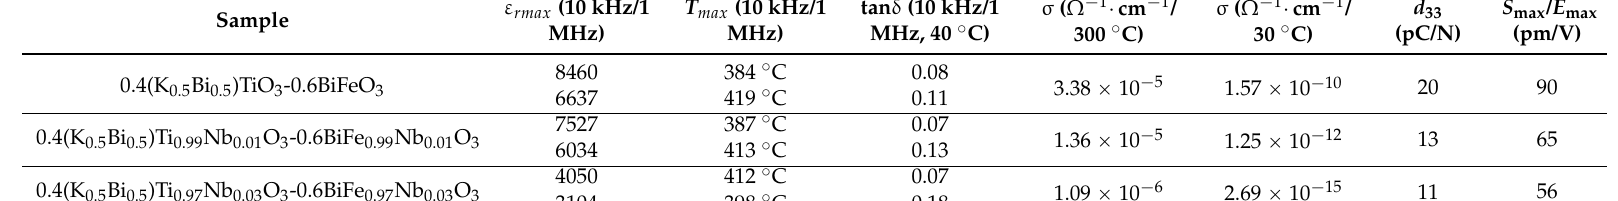
Table 2. Electrical properties of (K 0.5 Bi 0.5 )Ti 1 − x Nb x O 3 ‐ 0.6 BiFe 1 − x Nb x O 3 ceramics.